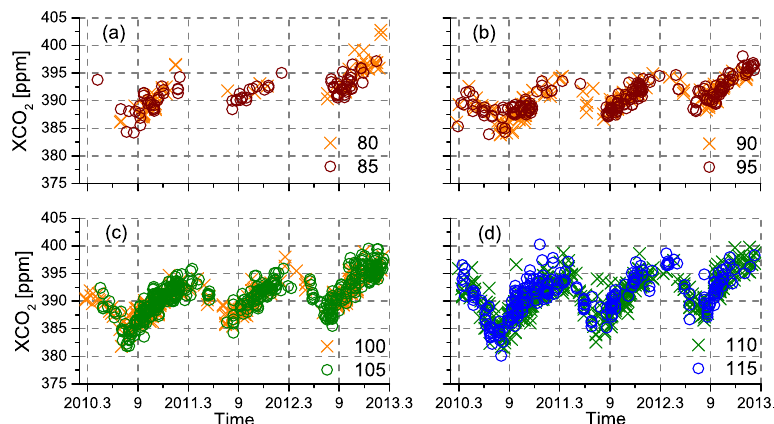
Figure A1. The time series of data points from ACOS V7.3 during the period from March 2010 to February 2013. Different symbols in each panel represent the left longi- tude of the cell into which a data point